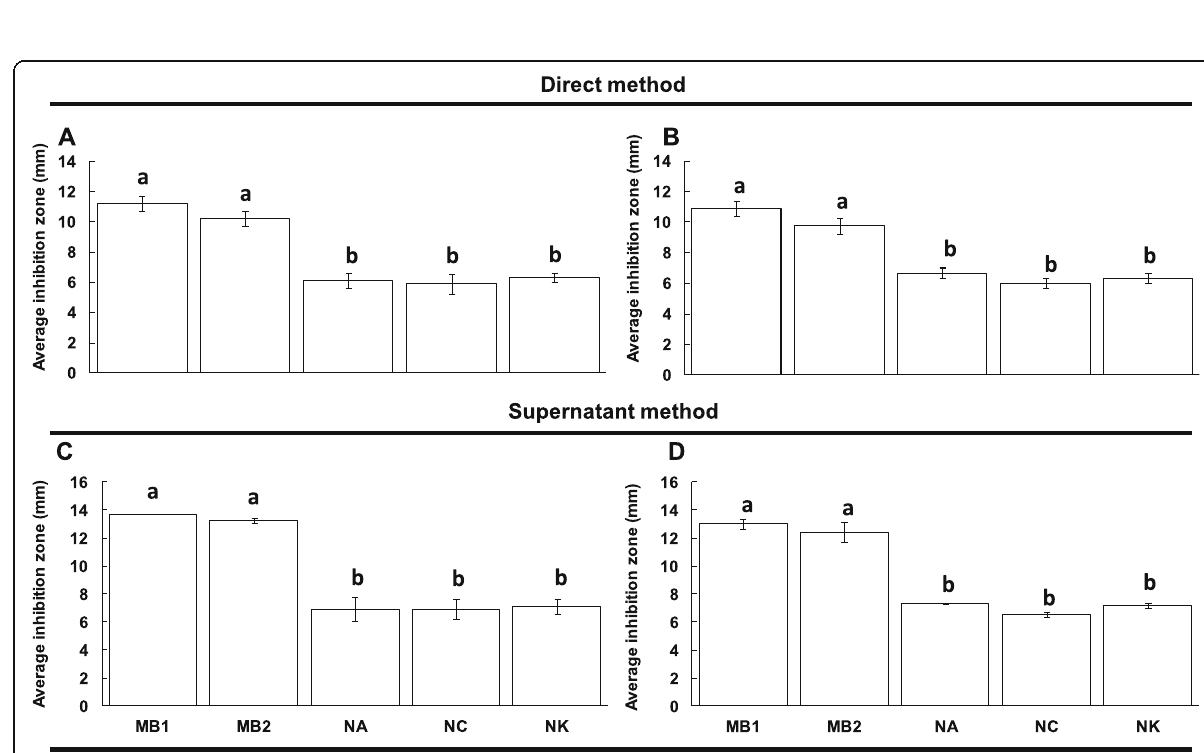
Fig. 3 Inhibition of growth of Erwinia amylovora ( A , C ) and Pectobacterium carotovorum ( B , D ) by candidate isolates Serratia plymuthica and Pseudomonas fluorescens , with direct method and supernatant method (means ± SD). Levels not connected by same letter are significantly (p < 0.05) different according to Tukey ’ s